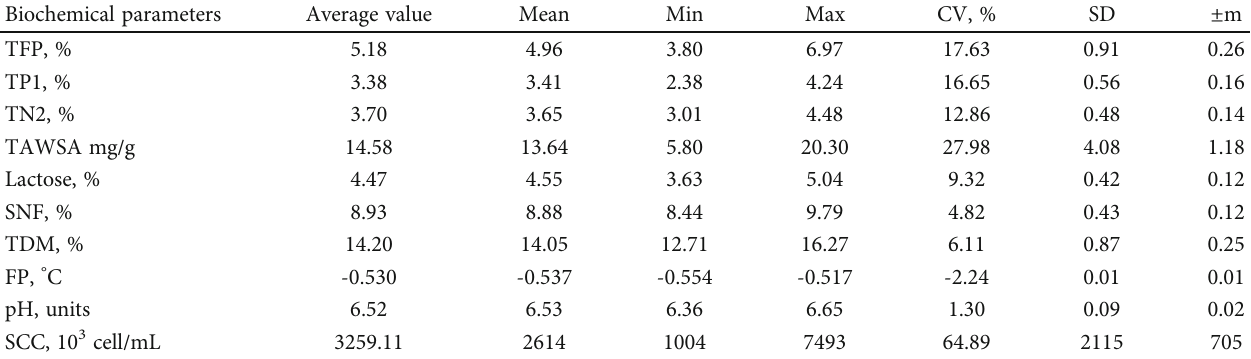
Table 4: The major biochemical parameters and component composition of milk samples ( n = 12 , group 4). Biochemical